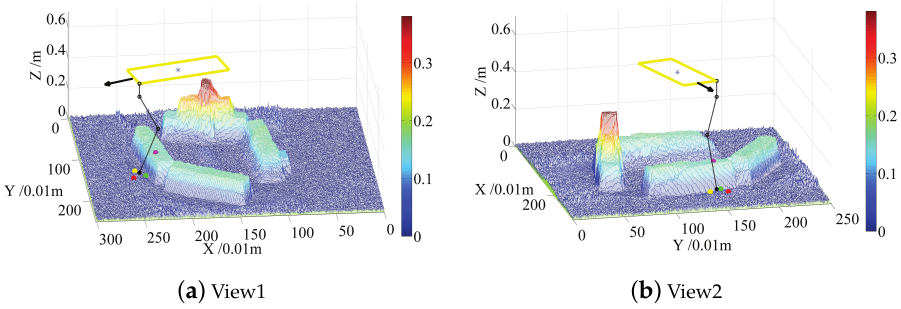
Figure 8. Candidate footholds randomly sampled around the left front default foothold for experts, and experts will sort these footholds by looking from several clear views. ( a ) the first view from which the expert can judge that the candidate foothold lies at the front of the default foothold or back; ( b ) the second view from which the expert can judge that the candidate foothold lies to the left of the default foothold or right.